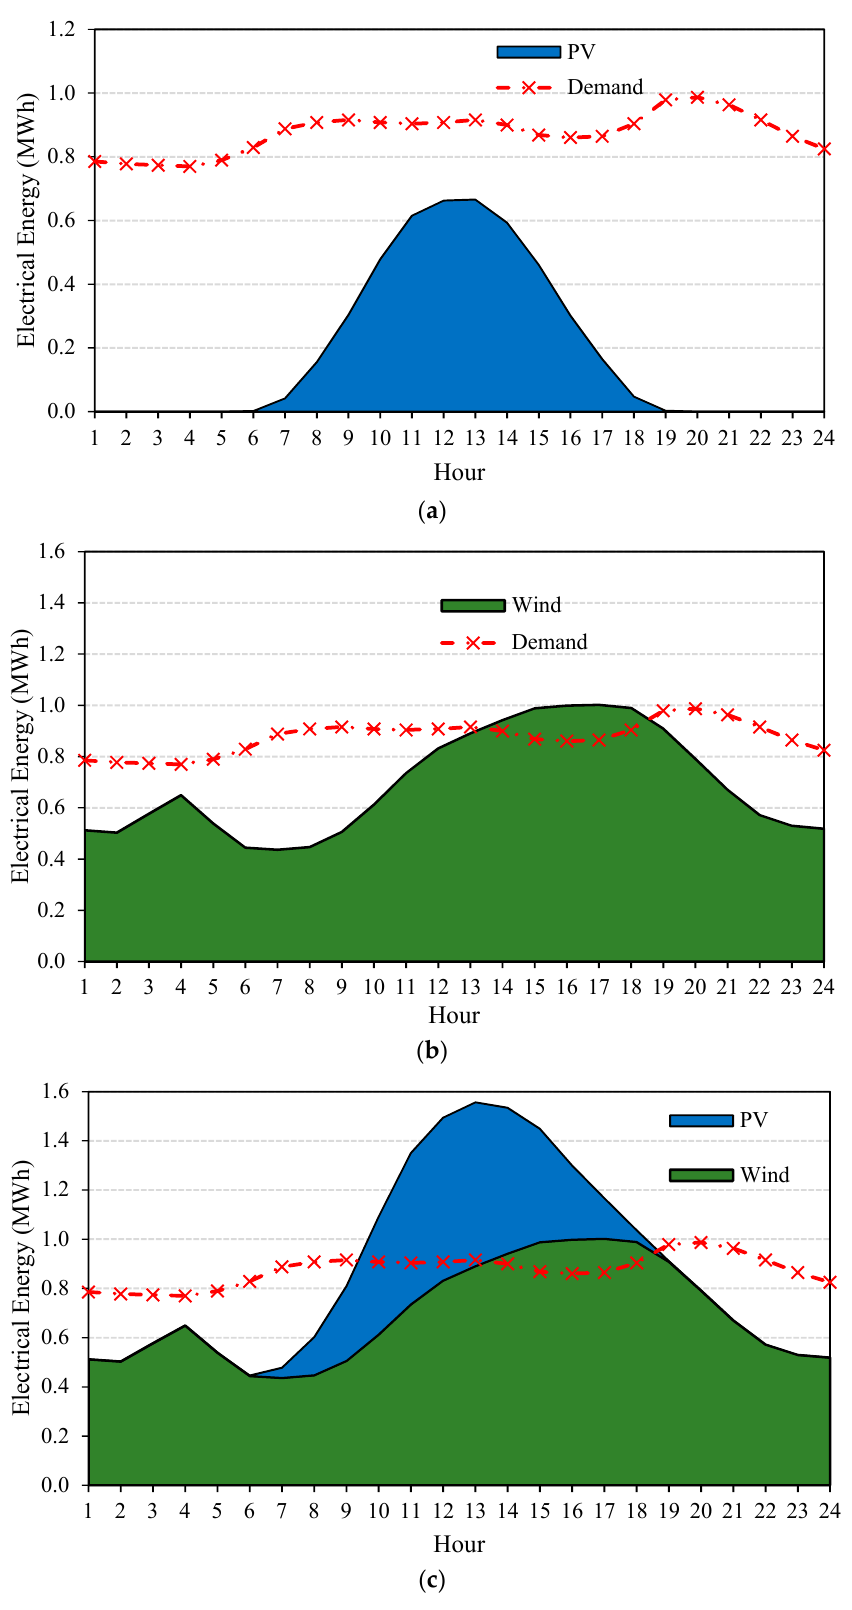
Figure 4. The average hourly energy generation from the maximum feasible: ( a ) PV system, ( b ) wind system and ( c ) PV-wind hybrid system in addition to the average hourly demand of